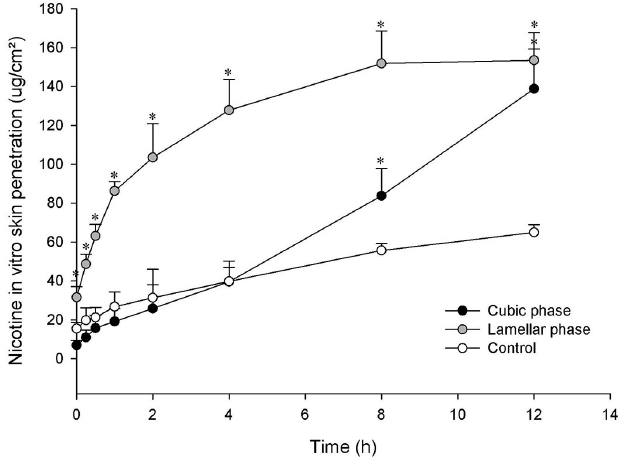
FIGURE 4 - Phase diagrams of Vitamin E TPGS/IPM/PG-H systems at (A) 3:1, (B) 1:1 and (C) 1:3 ratios with 0.25% (w/v) of nicotine. The phase regions are: filled circle birrefringence, filled square emulsion, filled triangle unstable emulsion, empty circle cubic phase, empty square lamellar phase, empty triangle isotropic liquid, gray circle cubic phase+water, gray square cubic phase+hexagonal phase, gray triangle hexagonal phase+water.